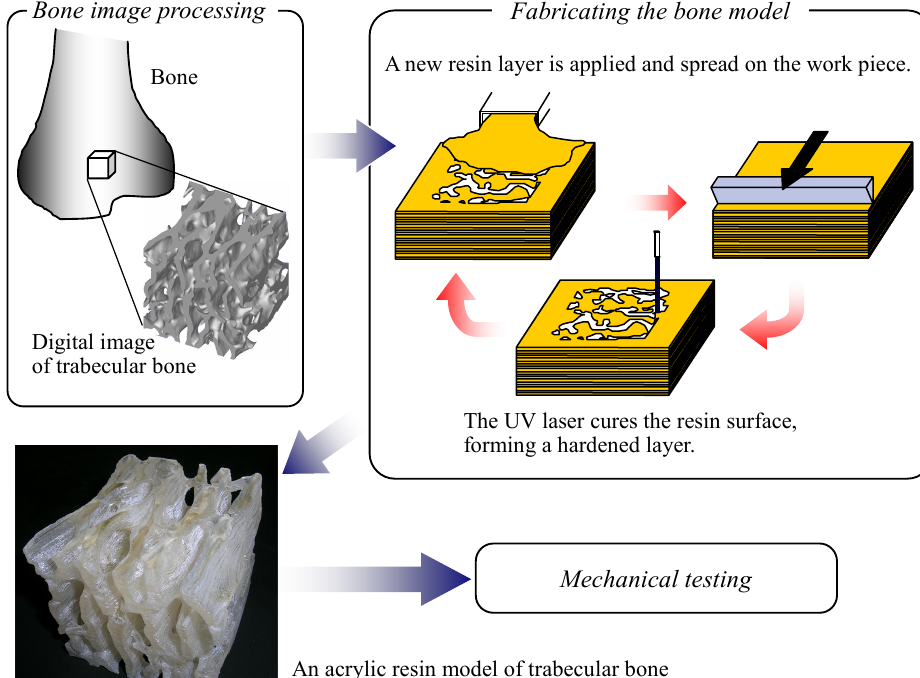
An acrylic resin model of trabecular bone